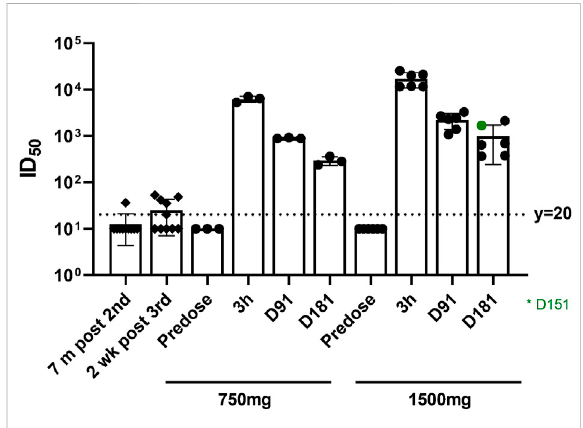
FIGURE 2 Neutralization activities Against the SARS-CoV-2 delta variant. The dotted line indicates the limit of detection of 20-fold